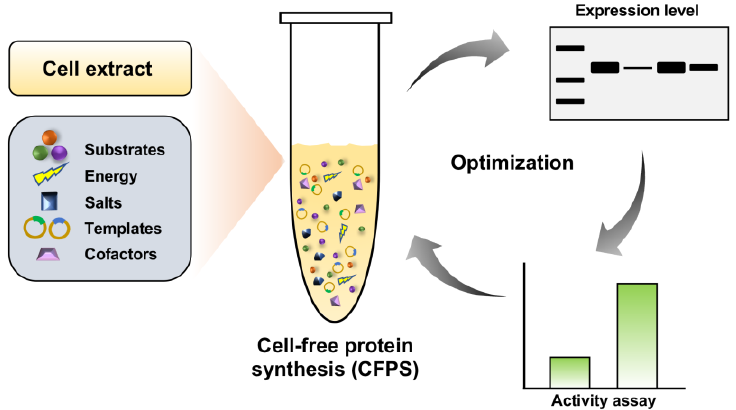
Figure 1. Schematic diagram of cell-free protein synthesis (CFPS) and optimization for soluble and active expression of serratiopeptidase.